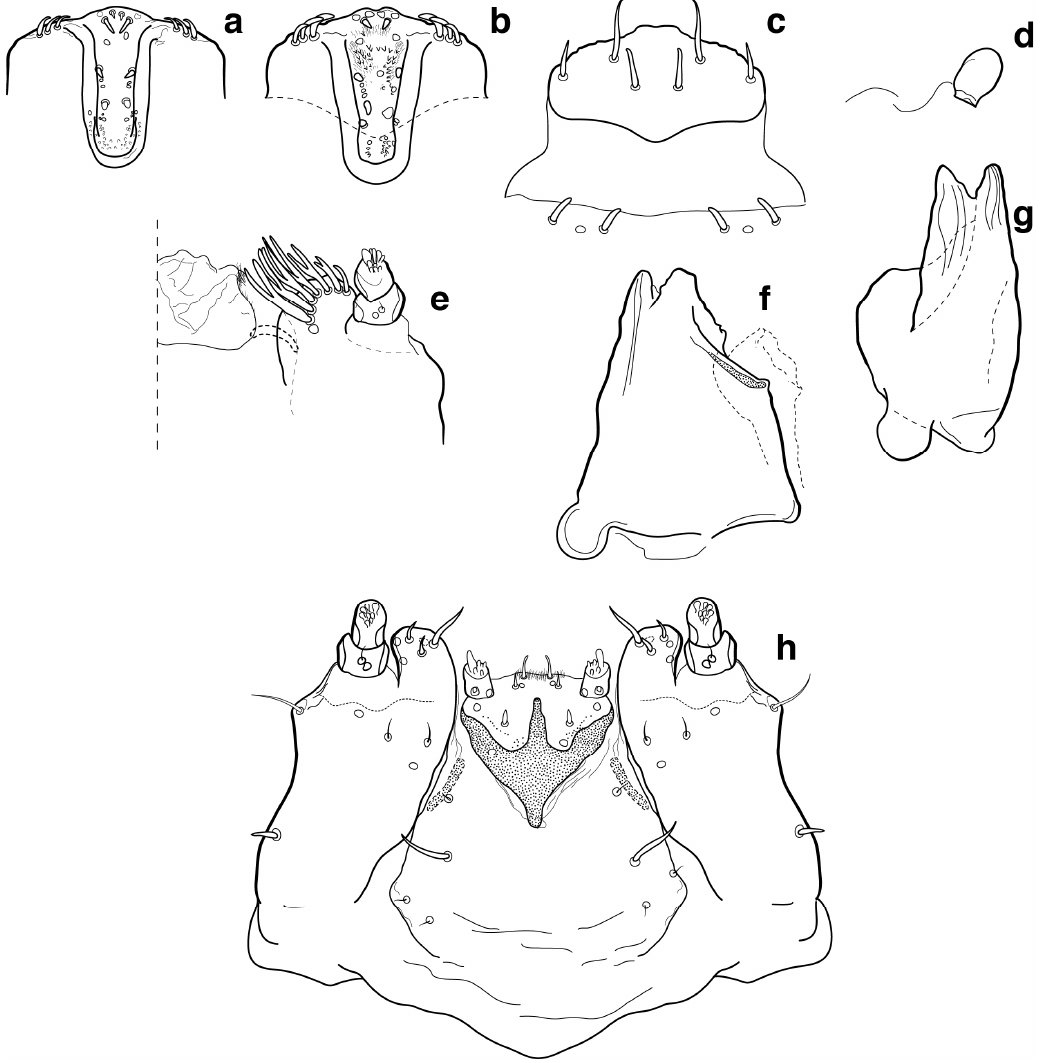
Figure 86. Stenommatus musae mouthparts: ( a ) epipharynx; ( b ) epipharynx, variation; ( c ) clypeus and labrum; ( d ) antennae; ( e ) mala, hypopharynx, maxillary palp, dorsal view; ( f ) mandible; ( g ) mandible; and ( h ) labio-maxillary complex, ventral view.